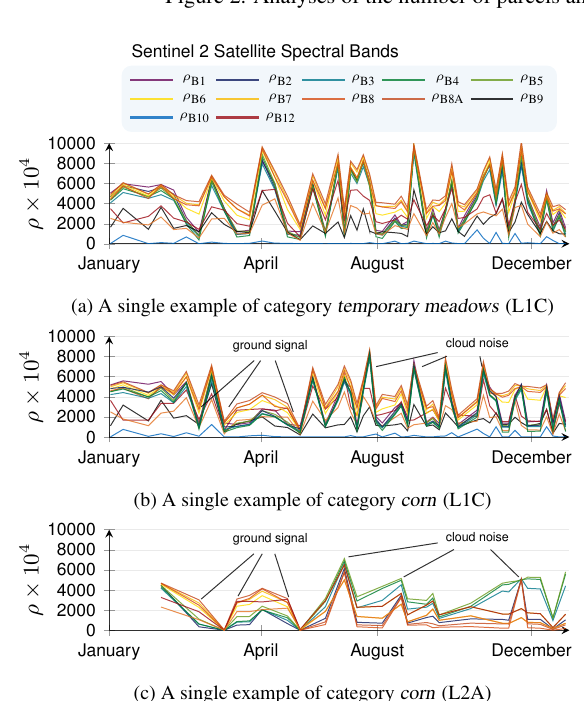
Figure 3. Examples of the input time series of top-of-atmosphere reflectances ρ for all 13 spectral bands of the Sentinel-2